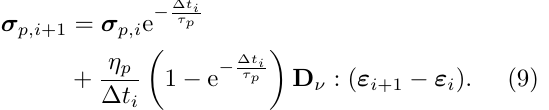
Figure 3. Time evolution of pressure recorded during the experimental